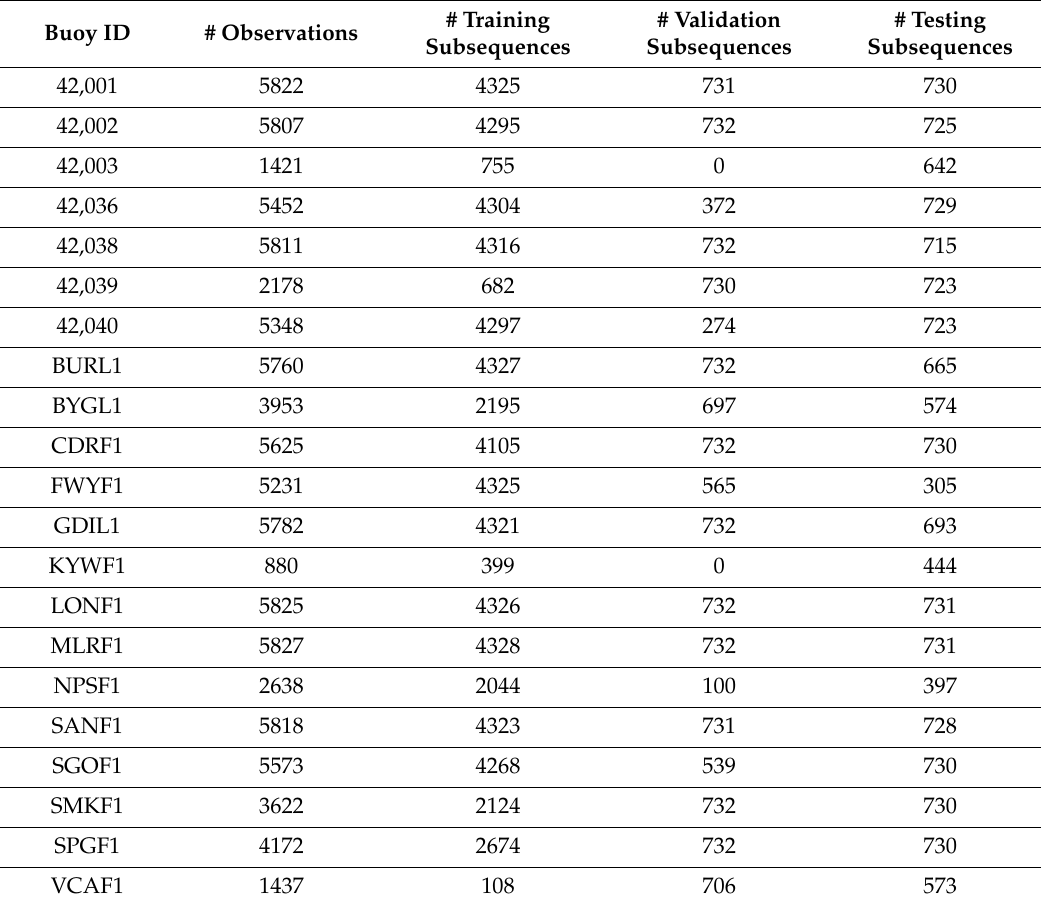
Table 1. Total number of observations belonging to each buoy and number of subsequences created for training, test, and validation